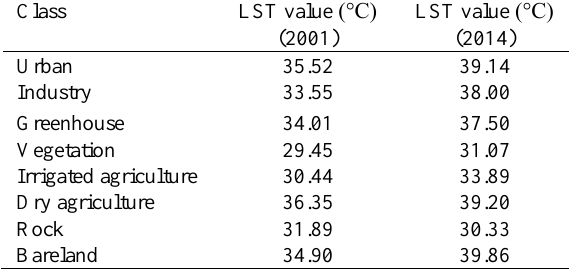
Table 5. LU/LC types and their LST values